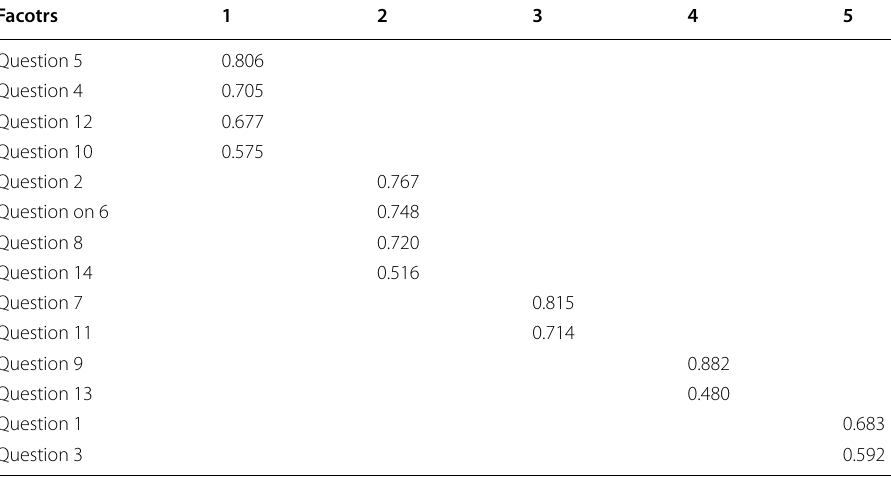
Table 4 Matrix of factorial weights rotated according to Varimax criterion